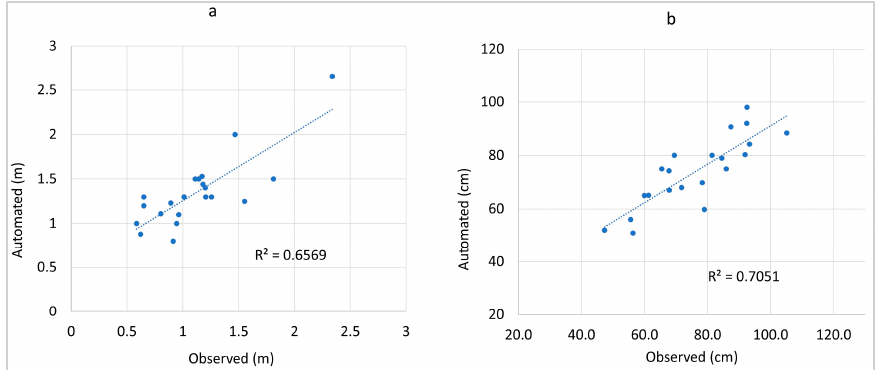
Figure 4. The scatterplots of the relationship between UAV predictions and the ground observation of stump height ( a ) and stump diameter ( b ).